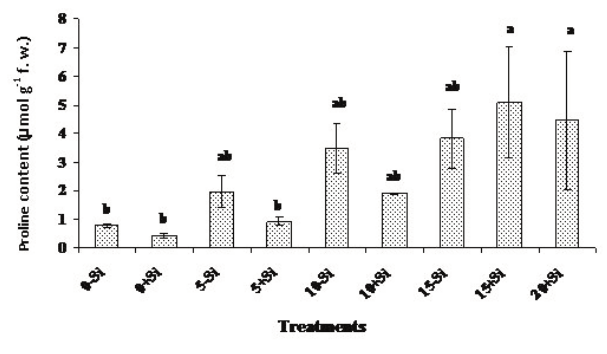
Fig. 5 - Effects of different salinity and Si levels on proline con- tent of Poa pratensis after 45 days. 0: control, 5, 10, 15